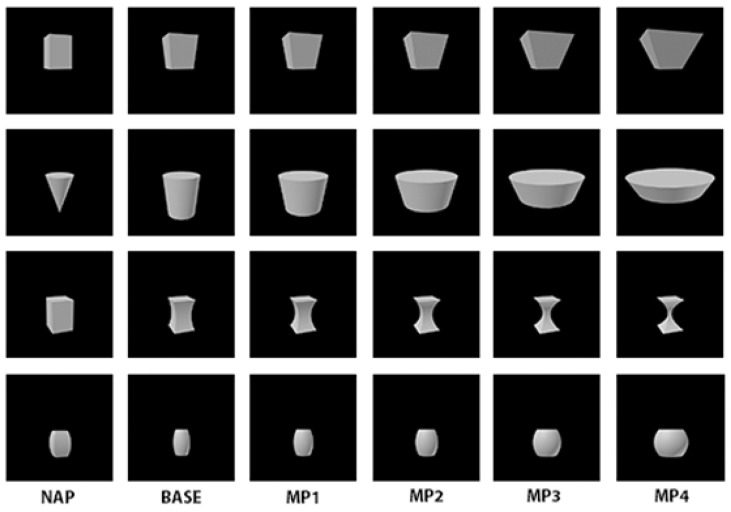
Sample stimuli from the study by Kayaert et al. (2003). The column labeled BASE corresponds to a reference image. The column labeled NAP corresponds to a transformation of the base image where an NAP was changed. MP1, MP2, MP3, and MP4 correspond to a transformation of the base image with an MP of increasing magnitude.